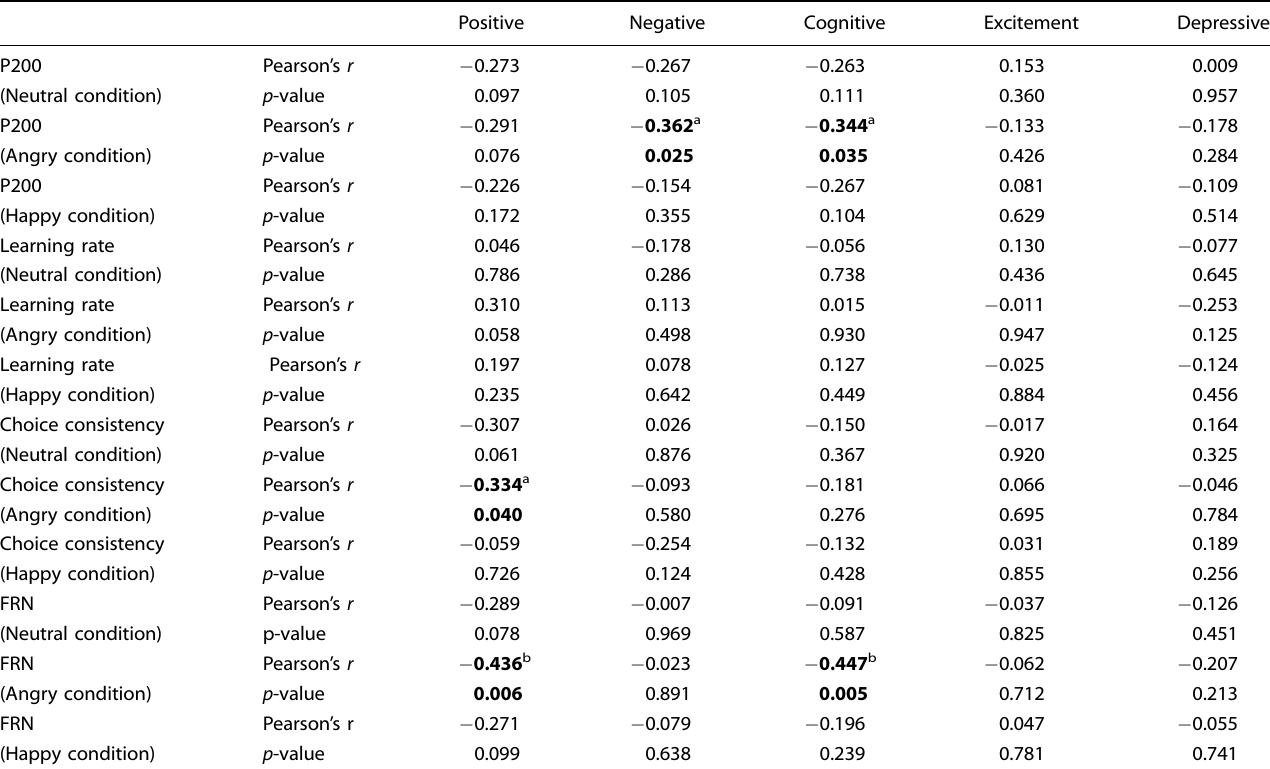
Table 1. Correlations between task measurements and symptom severity in patients with schizophrenia.